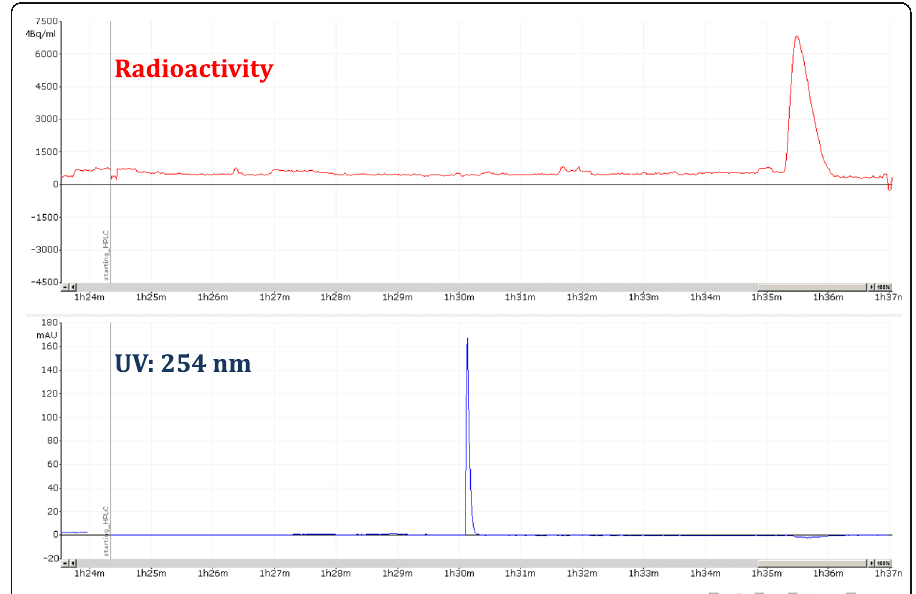
Fig. 8 A view of typical semi-preparative chromatogram of [ 18 F]fubatine